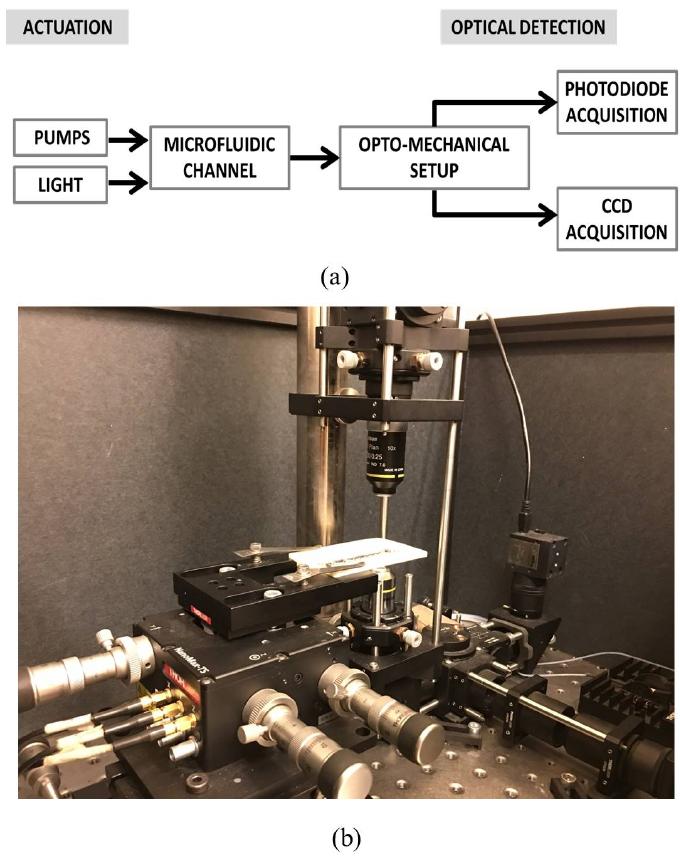
Figure 1. ( a ) The flowchart of the experimental set-up; ( b ) a picture of the opto-mechanical experimental